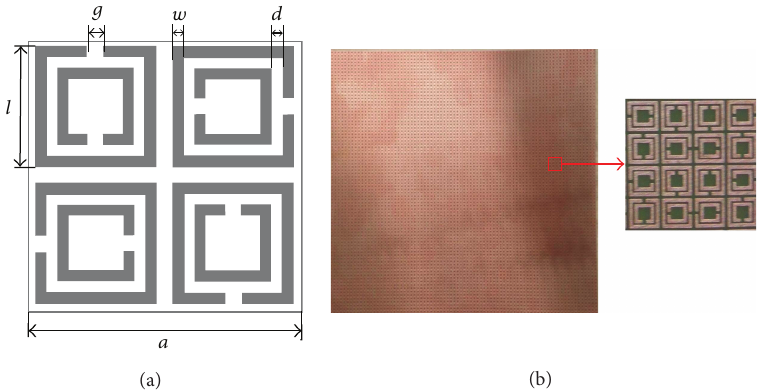
Figure 1: Schematic of MA: (a) unit cell with dimensions of 𝑎 = 5 , 𝑙 = 2.22 , 𝑔 = 0.3 , 𝑤 = 0.2 , and 𝑑 = 0.2 . (b) Photograph of the fabricated MA with 40 × 40 unit cells (dimension of 200 × 200). All units are in